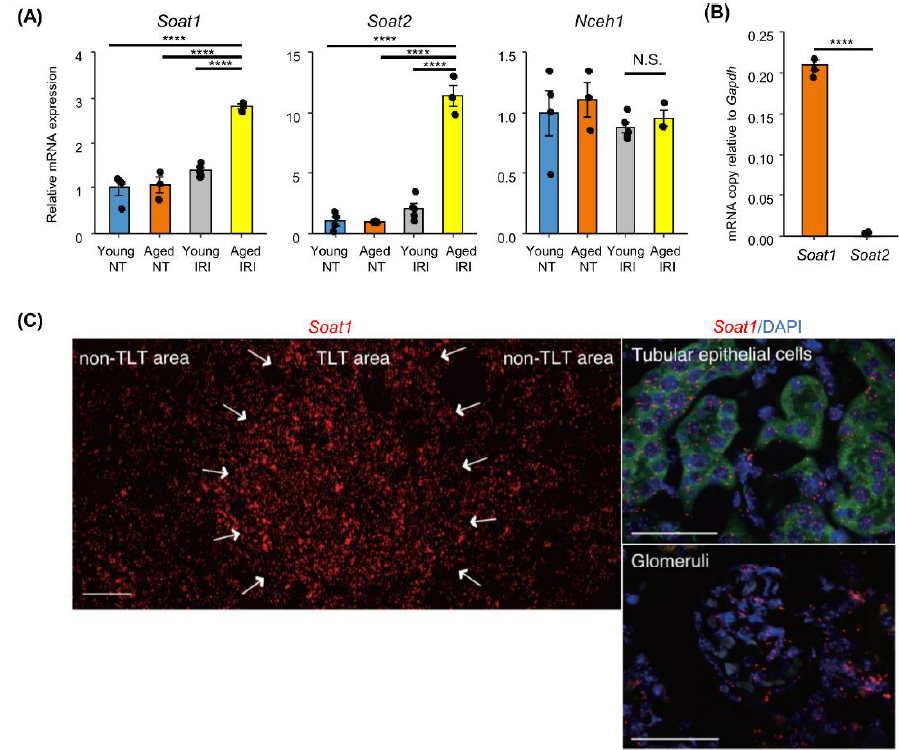
Figure 3. Soat expression in kidneys with TLT. ( A ) Relative mRNA expression of CE metabolizing enzymes. Young (8-week-old) and aged (12-month-old) mice 45 days after 45 min IRI or without IRI ( n = 3 – 5) were compared. Data are normalized with Gapdh and presented as fold change relative to young non-treated (NT) kidneys. ( B ) Comparison of Soat1 and Soat2 mRNA expressions in aged kidneys after IRI. The mRNA copy numbers per sample were obtained and normalized with Gapdh copy number per sample. ( C ) In situ hybridization of Soat1 (red) in kidneys 45 days after 45 min IRI. Arrows indicate TLT. In the image of tubular epithelial cells, the green staining represents background autofluorescence that was adjusted to show tubular structure. Scale bars: 50 μm. Values are mean ± S.E.M. Statistical significance was analyzed with ( B ) Tukey’s HSD test, and ( C ) student’s t -test. **** p < 0.0001. N.S. indicates not significant.